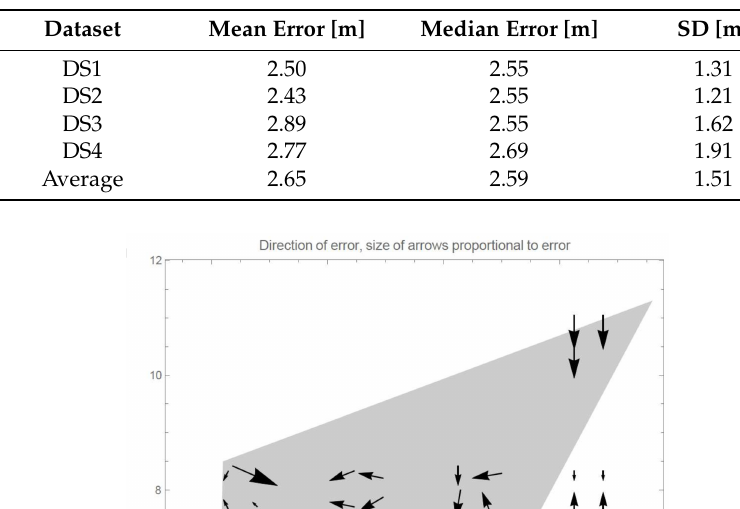
Table 1. Comparison of the mean and median errors made by Multiple Frequency Adaptive Model-based localization (MFAM) method utilizing WiFi (2.4 GHz) signals.